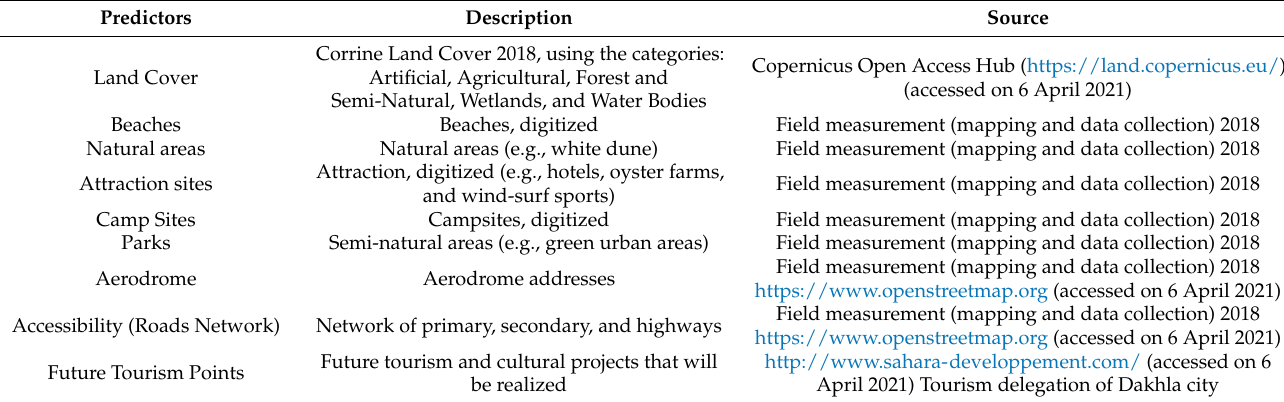
Table 1. List of landscape features and respective data sources in the InVEST model. Predictors Description Source Corrine Land Cover 2018, using the categories: Copernicus Open Access Hub (https://land.copernicus.eu/) Land Cover Artificial, Agricultural, Forest and (accessed on 6 April 2021) Semi-Natural, Wetlands, and Water Bodies Beaches Beaches, digitized Field measurement (mapping and data collection) 2018 Natural areas Natural areas (e.g., white dune) Field measurement (mapping and data collection) 2018 Attraction, digitized (e.g., hotels, oyster farms, Attraction sites Field measurement (mapping and data collection) 2018 and wind-surf sports) Camp Sites Campsites, digitized Field measurement (mapping and data collection) 2018 Parks Semi-natural areas (e.g., green urban